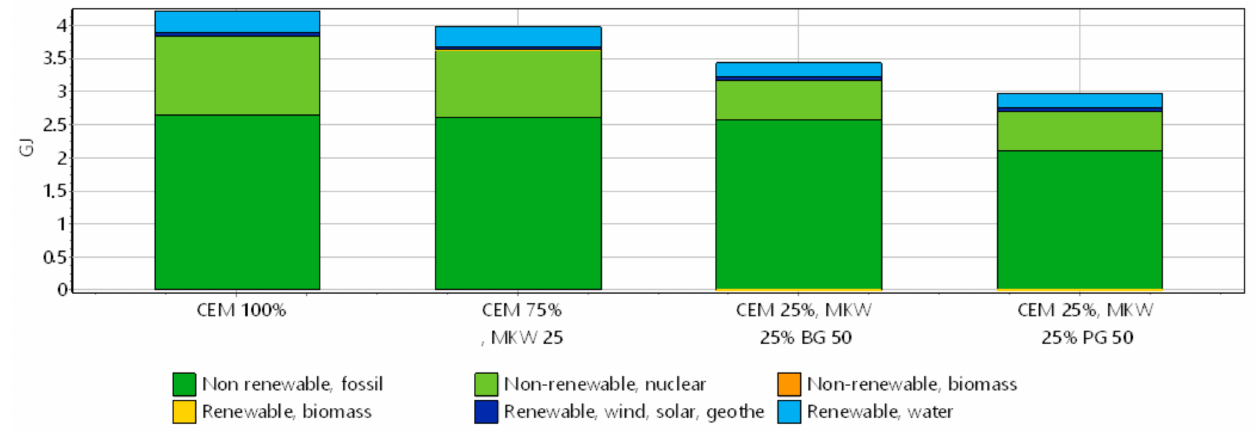
Figure 4. Total energy demand to produce 1m 3 of mortar.